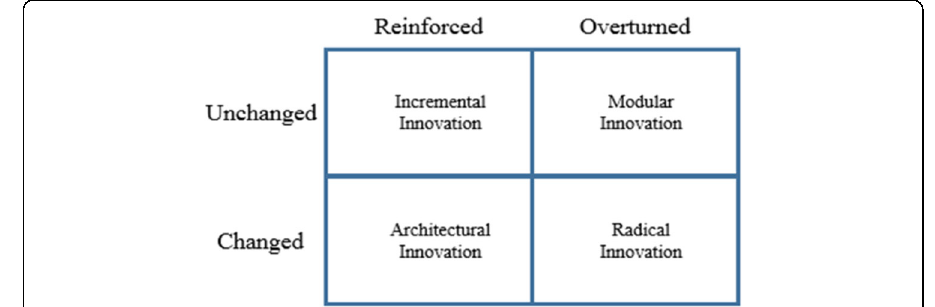
Fig. 1 A frame work for defining